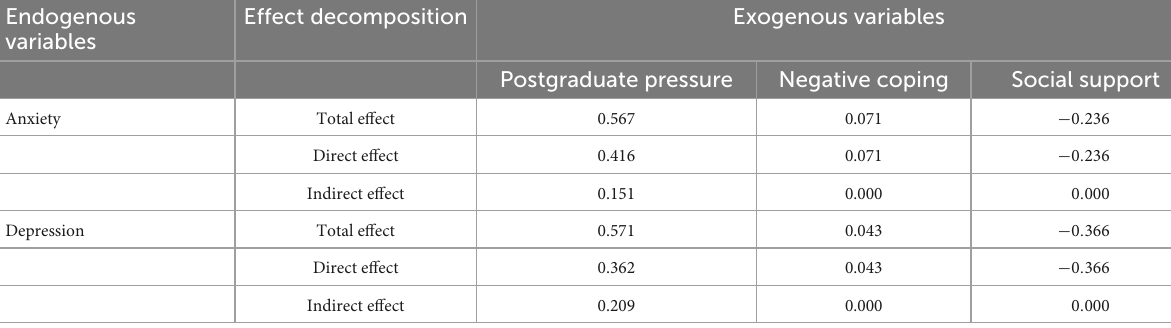
TABLE 4 The total, direct and indirect effects of the exogenous variables on the endogenous variables. Endogenous